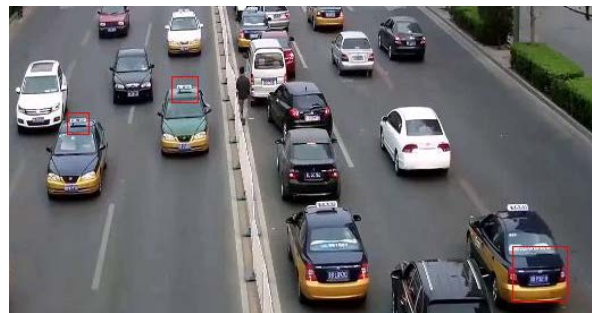
Fig. 10. Illustration of the ANN algorithm. A taxi is detected due to special sign but not as a